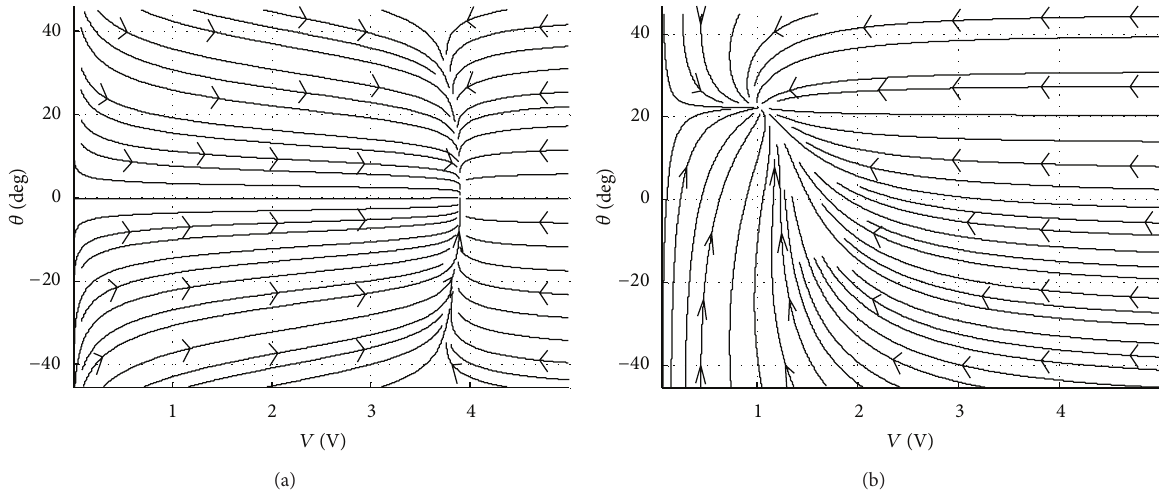
= 0.5 V. (a) for in + 𝑎 = 0.53 mA / V and nl in